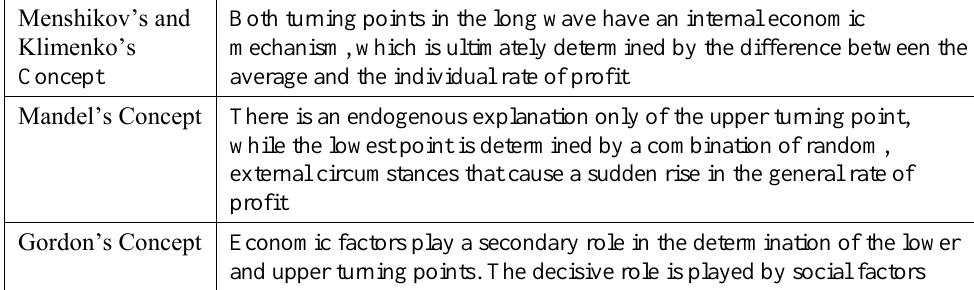
Table 6. Concepts of the cycles (Menshikov & Klimenko, 1989, p. 163) Menshikov’s